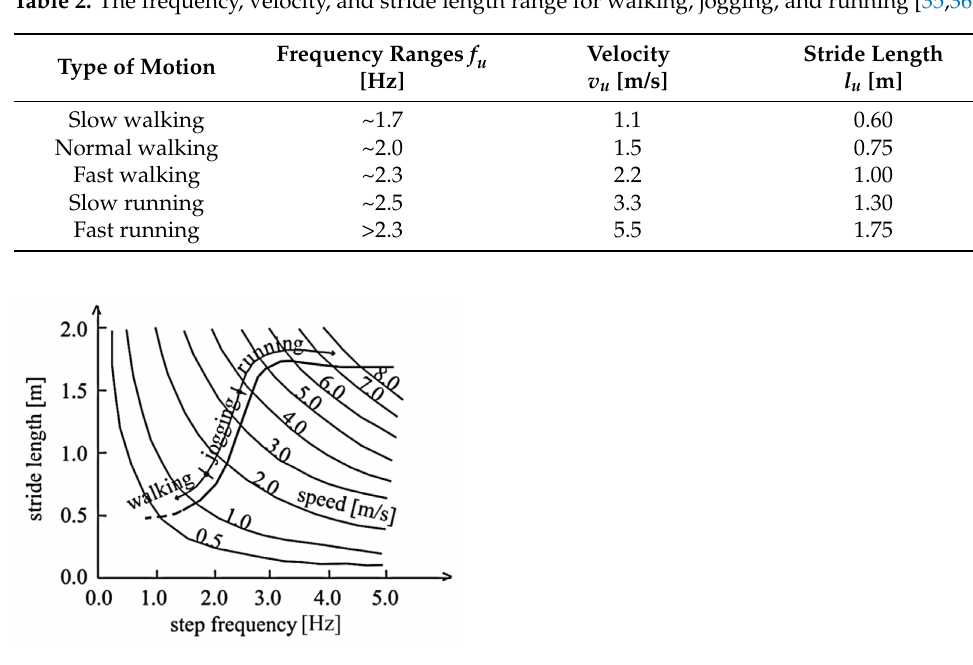
Figure 3. Frequency, velocity, and stride length range for walking, jogging, and running [35,36]. Table 3. The resonance risk levels and corresponding ranges of the natural frequencies